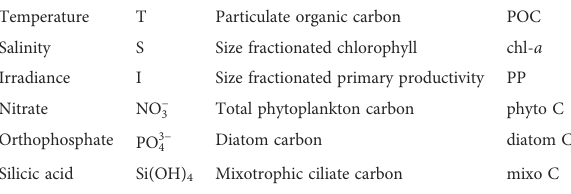
Size fractionated primary productivity PP Nitrate NO − 3 Total phytoplankton carbon phyto C Orthophosphate PO 3 − 4 Diatom carbon diatom C Silicic acid mixo C Abbreviations are given to the right of each